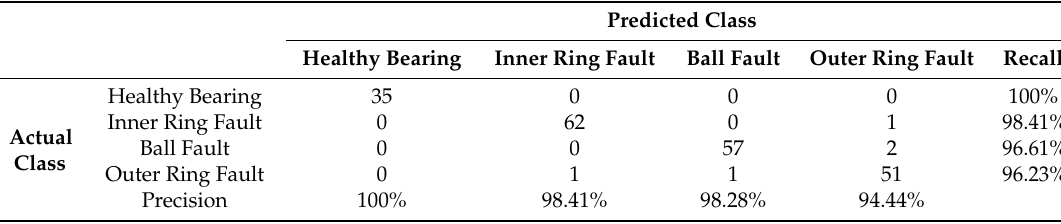
Table 6. Classification rate for Back-Propagation neural network (Testing data).